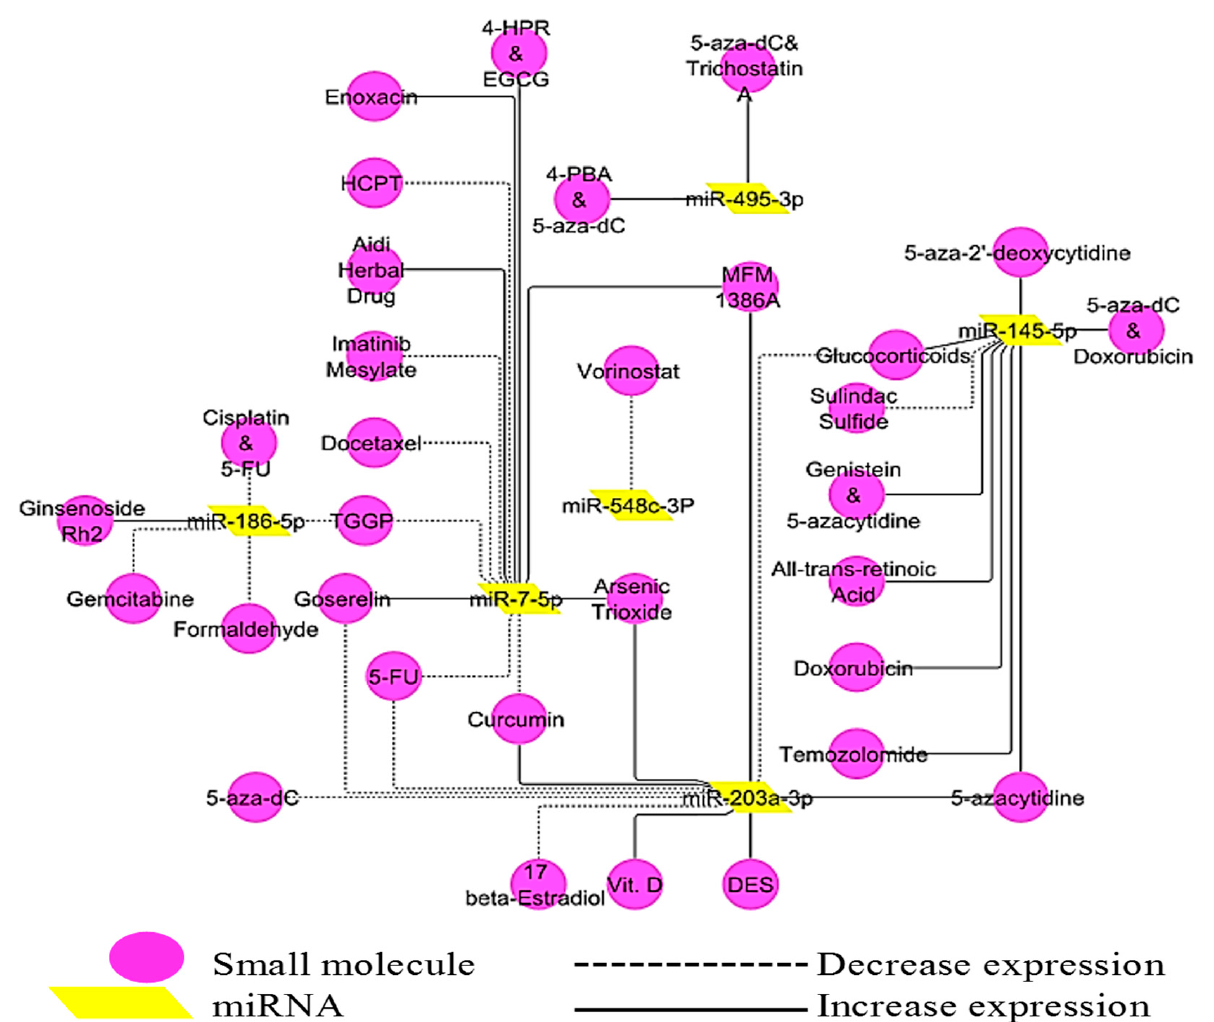
Figure 7. Interaction between miRNAs and small molecules. 4-PBA: 4-phenyl butyric Acid, 5-aza- dC = 5-aza-2 ′ -deoxycytidine, TGGP: 1,2,6-Tri-O-galloyl- β -D-glucopyranose, HCPT: Hydroxycamp-